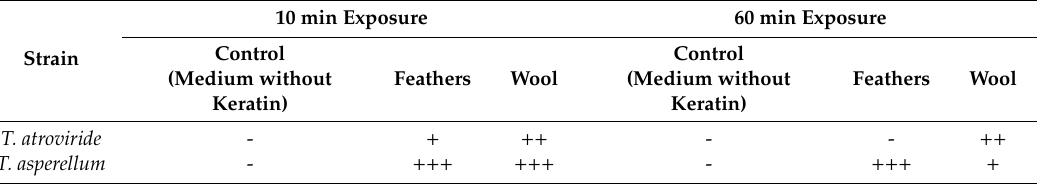
Table 4. Apparent activation of proton pump of tomato seedlings based on the bromocresol assay. 10 min Exposure 60 min Exposure Control Control Strain (Medium without Feathers Wool (Medium without Feathers Keratin) Keratin)